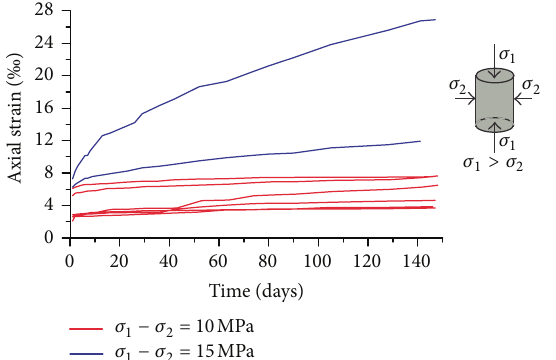
Figure 5: Selected triaxial creep tests results obtained for rock salt samples from the Polkowice-Sieroszowice copper ore mine [10].